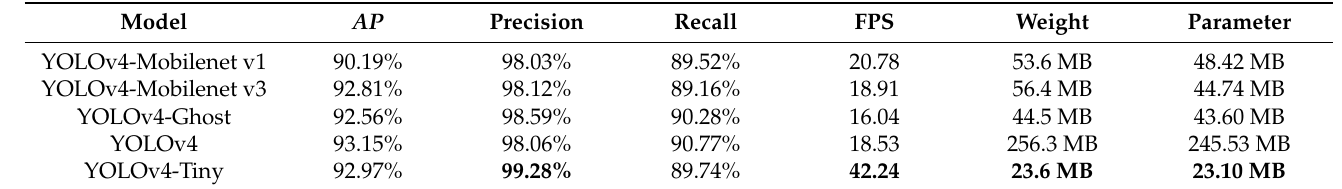
Table 1. Comparison of the performance of different